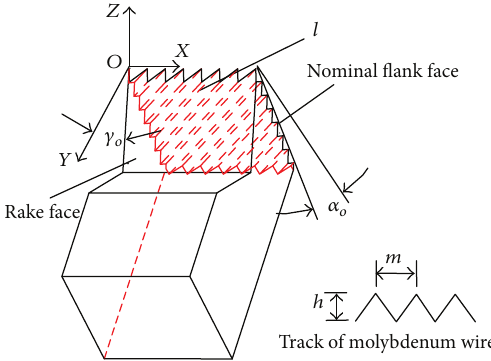
Figure 1: Schematic drawing of multitooth